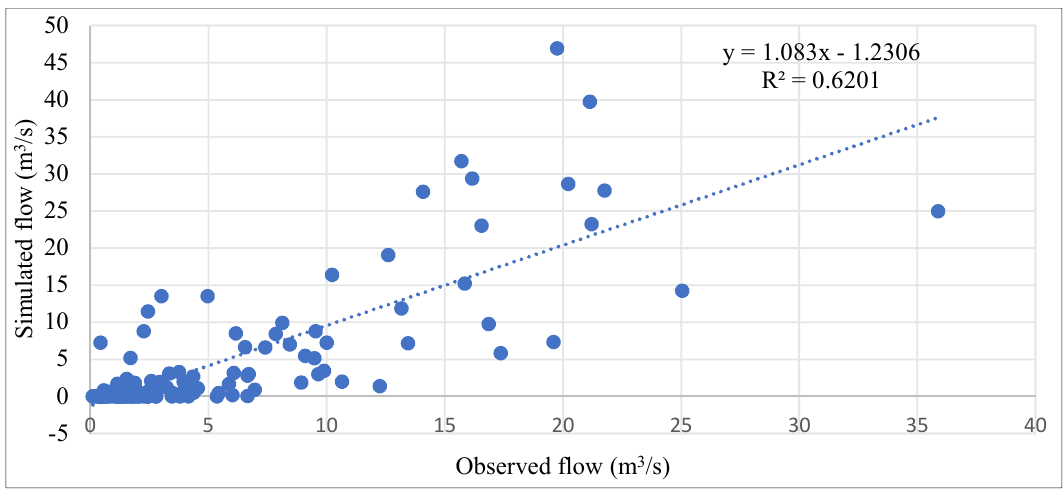
Figure 6. A scatterplot of the observed and simulated streamflow at gauging station 4CB04.